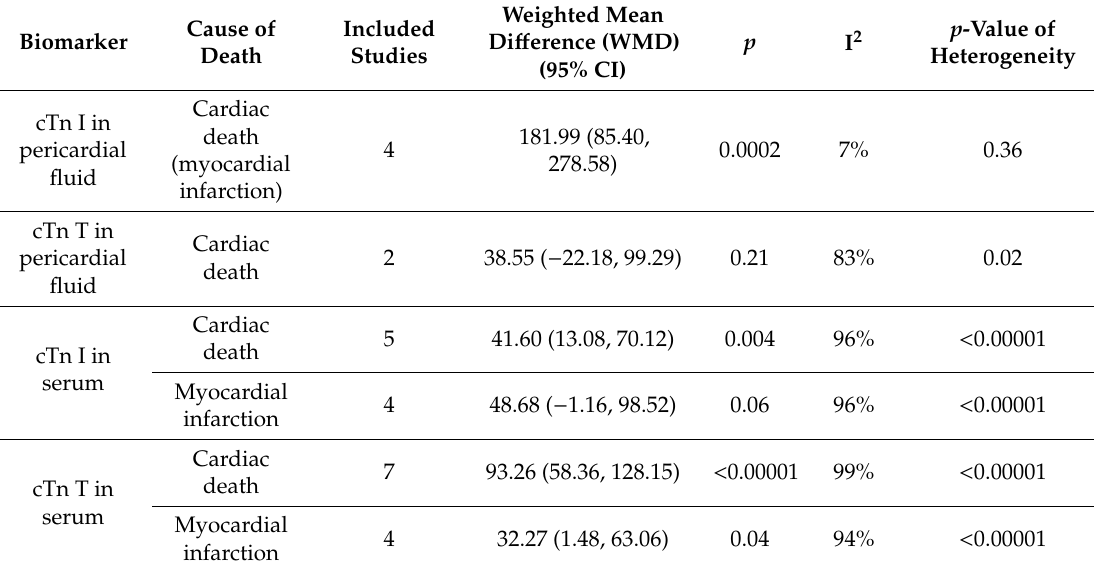
Table 2. The main results of subgroup analysis.